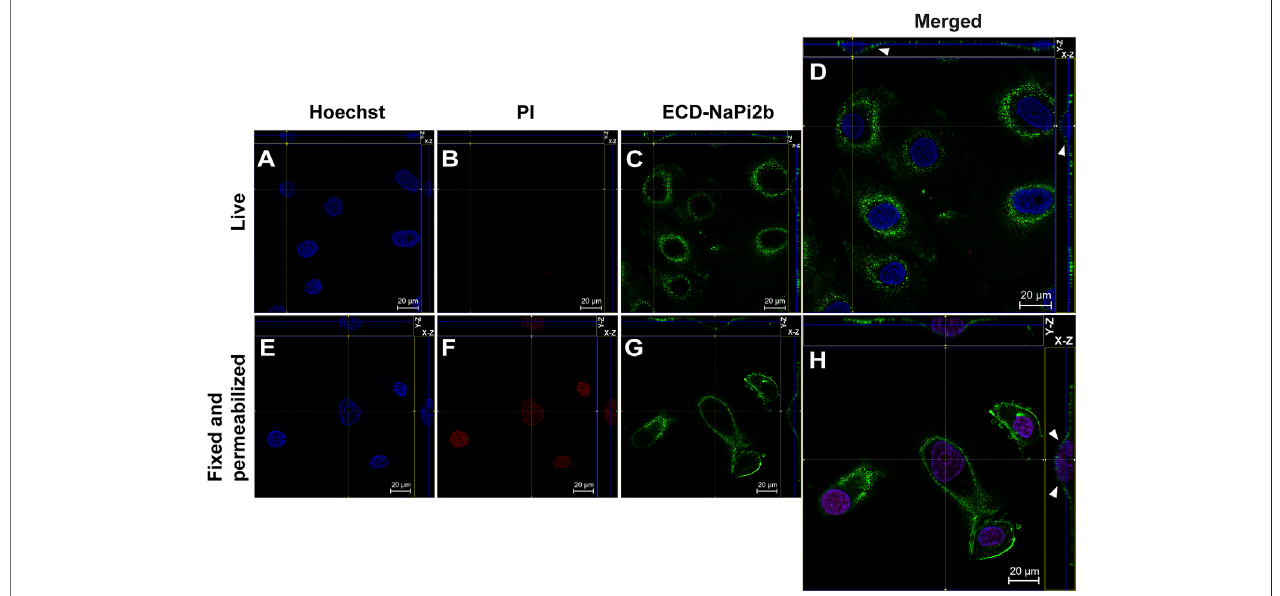
FIGURE 1 | Confocal microscopy analysis of the largest extracellular domain of NaPi2b in ovarian carcinomas cells OVCAR-4 that were either alive (A – D) or fi xed and permeabilized (E – H) and imaged in the Z-stacking mode. (A,E) Blue channel (Hoechst); (B,F) Red channel (PI); and (C,G) Green channel (Alexa Fluor 488), ECD- NaPi2b – mAbs L2 (20/3) directed to ECD of NaPi2b; (D,H) Merged images; On the top ( Y -axis and Z -axis combined) and right ( X -axis and Z -axis combined) of each picture, a composite image comprising of numerous photographs obtained at various focus distances is shown. White arrows indicate the position of NaPi2b on the cell